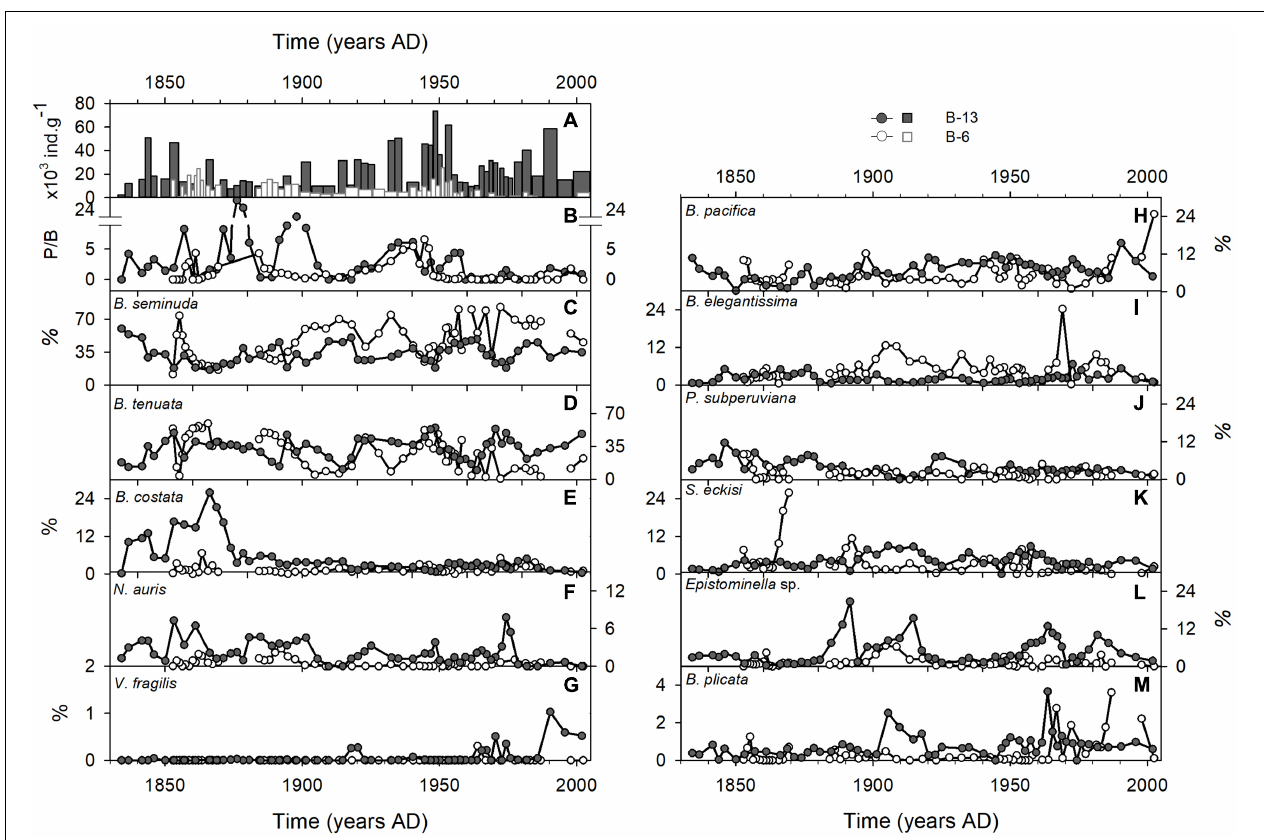
FIGURE 3 | Records of foraminifera in in Callao (B-13, black circles) and Pisco (B-6, white circles) box cores: (A) Total densities; (B) P/B ratio and (C–M) relative abundances (%) of main benthic foraminiferal species.